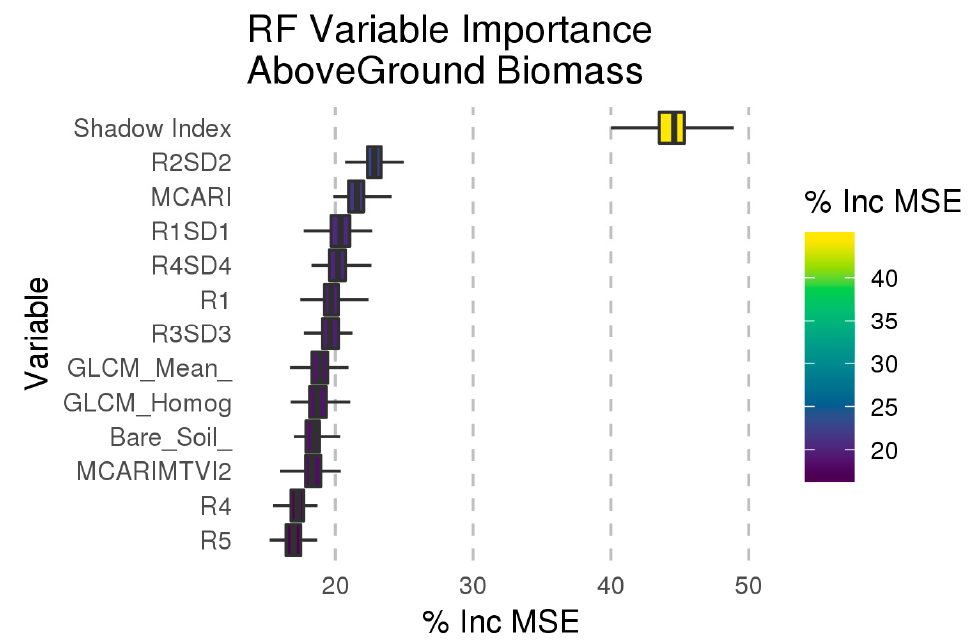
Figure 5. Box-plot of the importance of variables for AGB in the final Random forest model, showing the increase in mean standard error (MSE) when removing a variable ( y -axis), and their importance on the x-axis. For the sake of simplicity, only the first 12 variables are shown. RXSDX denotes the ratio of the band X reflectance to its standard deviation.